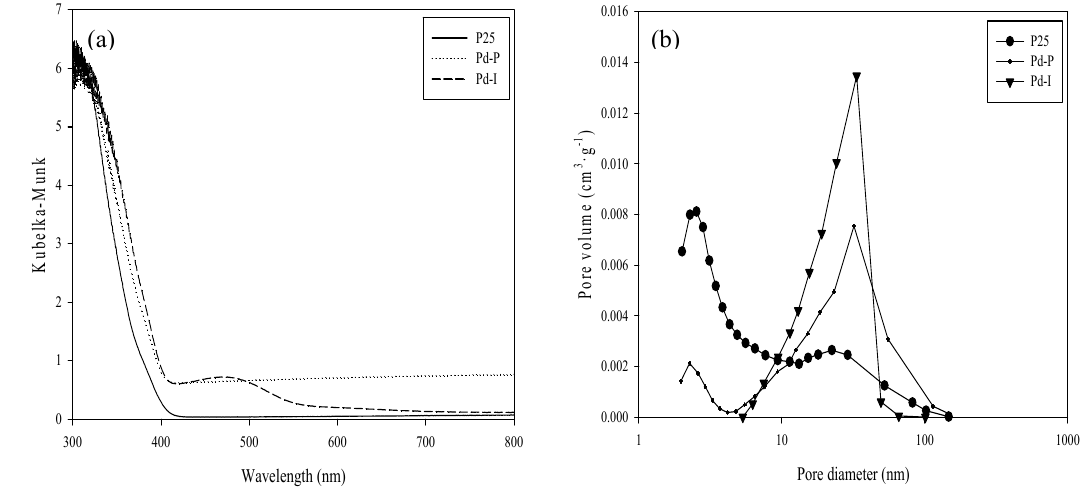
Figure 2. ( a ) UV-vis diffuse reflectance spectra and ( b ) Pore volume distribution of the catalysts.